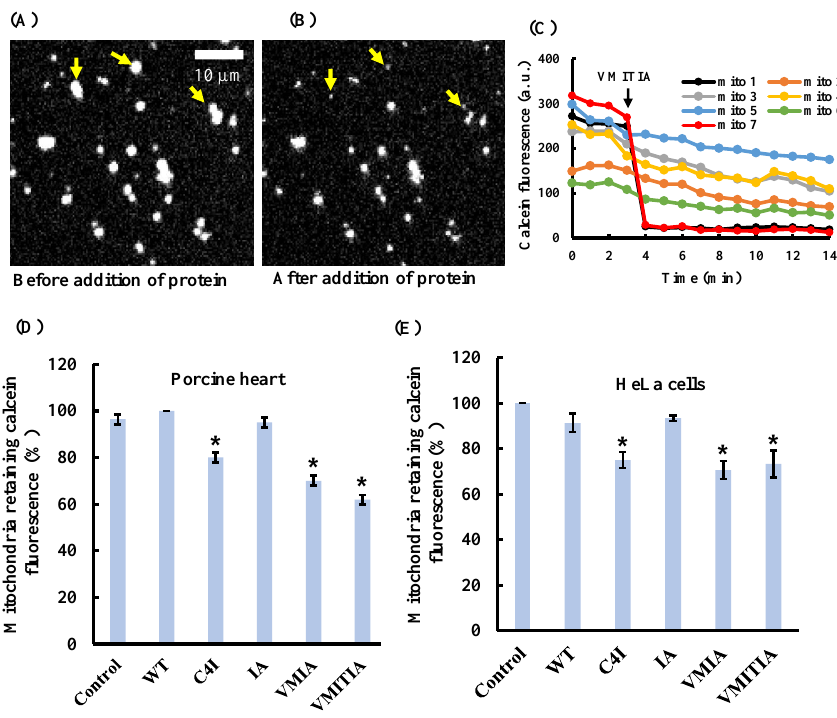
Figure 2. Effects of DENV3-ED3 variants on mitochondrial inner membrane integrity. ( A , B ) Calcein fluorescence images of mitochondria isolated from porcine hearts. Fluorescence images of the same microscopic field ( A ) before and ( B ) after the addition of 50 µ M VMITIA. Arrows indicate mitochondria that released calcein after VMITIA addition. Bar, 10 µ m. ( C ) time course of changes in calcein fluorescence in seven isolated mitochondria. VMITIA (50 µ M) was added at t = 3 min. ( D , E ) Percentage of mitochondria that retained calcein fluorescence after 10 min exposure to the indicated DENV3-ED3 variant (50 µ M) at 37 ◦ C. Control mitochondria were treated with Tris sucrose buffer alone; ( D ) mitochondria isolated from porcine hearts and ( E ) HeLa cells. Data represent the mean ± SEM of three independent experiments. Over 50 mitochondria were analyzed per